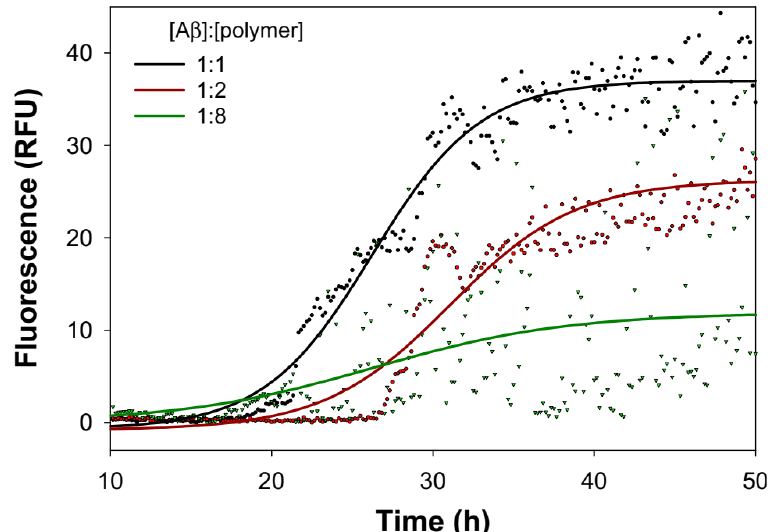
Figure 5. Representative kinetic profiles of the amyloid aggregation due to the co-incubation of A β 1-40 (20 µ M) with PGA β CyDArg2, the (A β )/(Polymer) molar ratio ranging from 1:1 to 1:8. Single points represent the experimental data, whereas the straight lines are the fitted curves (adjusted R 2 is 0.9766, 0.9481 and 0.7227 for 1:1, 1:2, 1:8 (A β )/(Polymer) molar ratio,